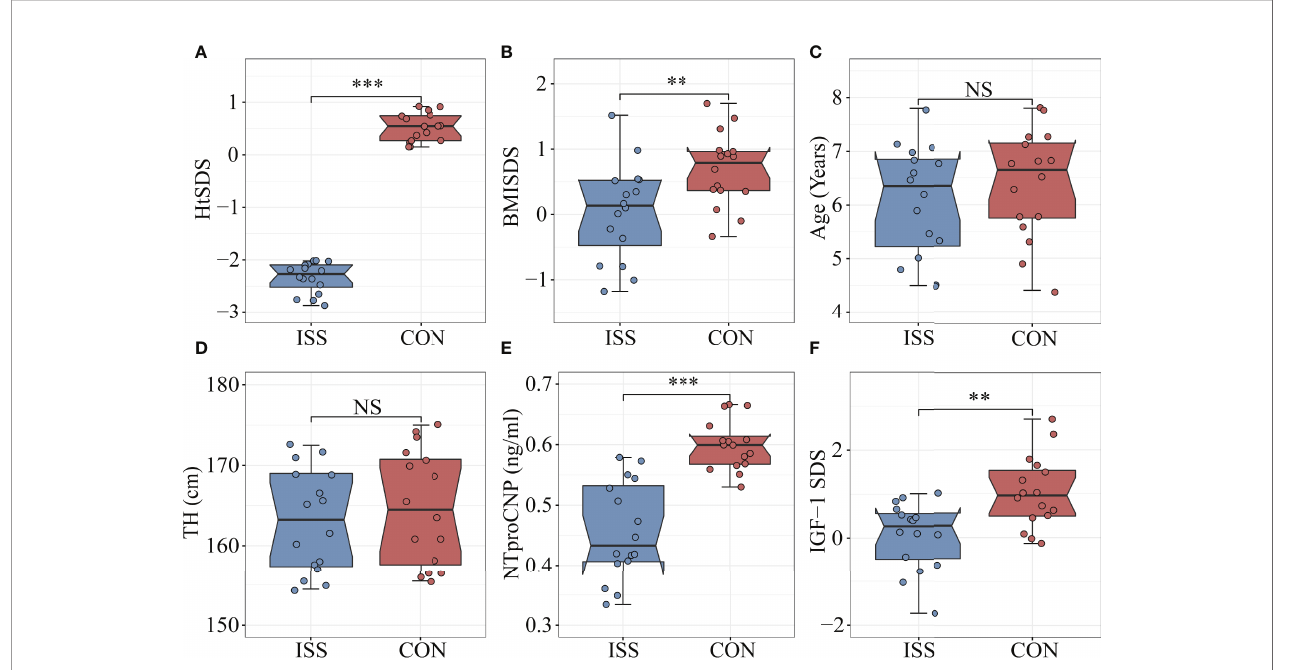
FIGURE 1 | Comparison of biomarkers and Clinical features between ISS patients and healthy controls. (A) HtSDS; (B) BMI-SDS; (C) Age; (D) Target height; (E) NTproCNP; (F) IGF-1 SDS. ** P < 0.01; *** P < 0.001. HtSDS, height standard deviation score; BMI SDS, body mass index standard deviation score; TH, target height; NTproCNP, amino-terminal propeptide of C-type natriuretic peptide; IGF-1 SDS, insulin like growth factor standard deviation score. NS, no signi fi